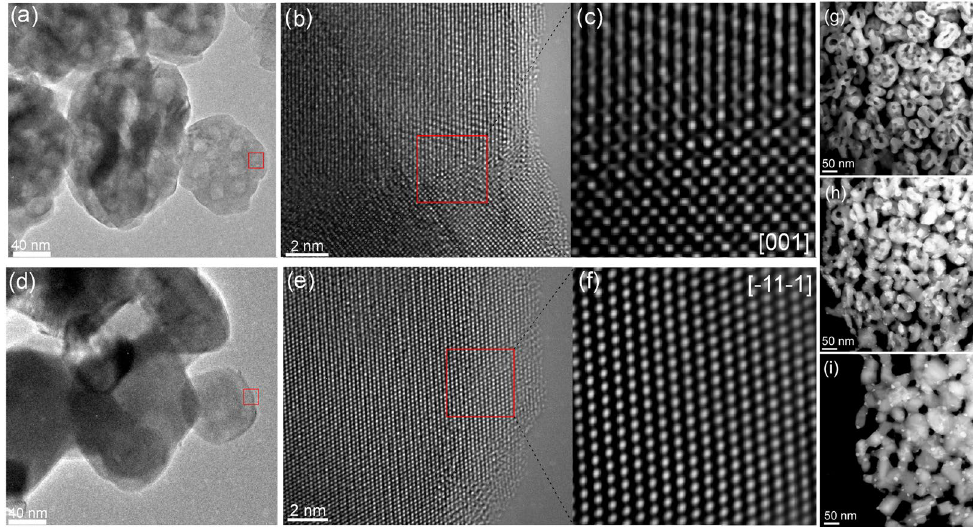
Figure 2. Observed 3YSZ crystallite coalescence within the secondary particle agglomerate into smaller, but denser, entities during the initial stage of rapid sintering (RS) in the TEM heating stage. ( a ) TEM image of the 3YSZ secondary particle agglomerate prior to RS. ( b ) High-magnification image of the area marked with a red rectangle from a and, ( c ) HRTEM image showing a boundary between two neighbouring nanocrystals forming the secondary mesoporous particle. ( d ) TEM image of the same site as in a after RS at 250 °C/min to 1200 °C with no dwell time. ( e ) High-magnification image of the rectangle from d indicating the absence of crystallite boundaries and, ( f ) HRTEM image showing single-crystalline nature of the initially polycrystalline, secondary 3YSZ nanoparticle from a after RS. TEM dark-field micrographs of 3YSZ bulk body intersecting the heating process at ( g ) 600 °C, ( h ) 1100 °C, and ( i ) 1200